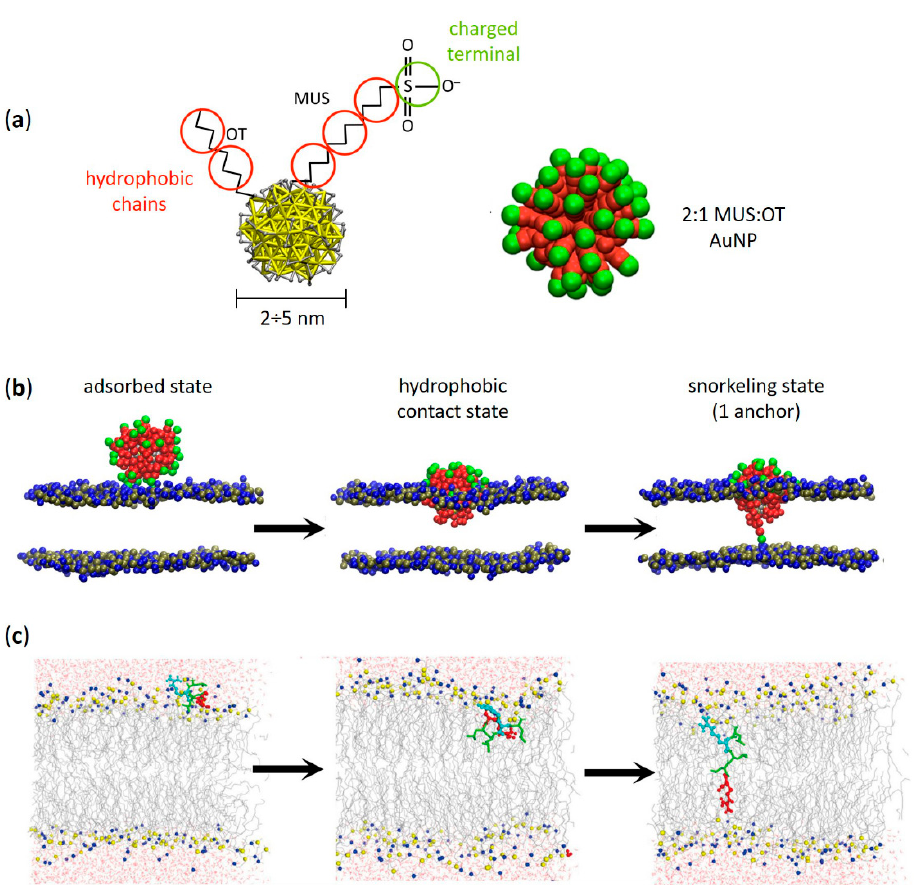
Figure 1. Amphiphilic AuNPs and amphiphilic peptides: similarities between their spontaneous penetration mechanism into lipid membranes. ( a ) Structure of an amphiphilic MUS:OT AuNP with its coarse-grained (CG) representation (2:1 MUS:OT ligand ratio). Red beads represent hydrophobic carbon groups, while green beads represent the charged MUS terminals. ( b ) Different stages of penetration of a MUS:OT AuNP into a 1-palmitoyl-2-oleoyl-glycero-3-phosphocholine (POPC) lipid bilayer obtained from CG molecular dynamics simulations. From left to right: adsorbed state, hydrophobic contact state, and snorkeling of the first MUS ligand which binds to the opposite leaflet. Eventually—through a sequential anchoring process—more and more MUS ligands are dropped leading to the fully snorkeled configuration of the NP-membrane complex. Lipid heads are blue (choline) and tan (phosphate), lipid tails and water are not shown. ( c ) Translocation process of an amphiphilic ‘Spontaneous Membrane-Translocating Peptide’ (SMTP) into a POPC lipid bilayer obtained from united atom bias-exchange metadynamics simulations. Specifically, the SMTP contains a LRLLR sequence composed of two Arg (R) and three leucines (L) residues. From left to right: SMTP located in the lipid head region, SMTP on its way towards the opposite leaflet, and final snorkeled configuration. The first Arg is shown in cyan, the second Arg is shown in red, and leucine hydrophobic residues are shown in green. Nitrogen and phosphorus atoms in the lipid head region are shown in blue and yellow, respectively. The lipid tails are shown as thin gray lines, while water is shown as red (oxygen) and gray (hydrogen) cylinders. ( a , b ) adapted with permission from Simonelli et al. [38]—Copyright © 2015 American Chemical Society. ( c ) reprinted with permission from Cao et al. [51]—Copyright © 2020 Elsevier B.V. All rights